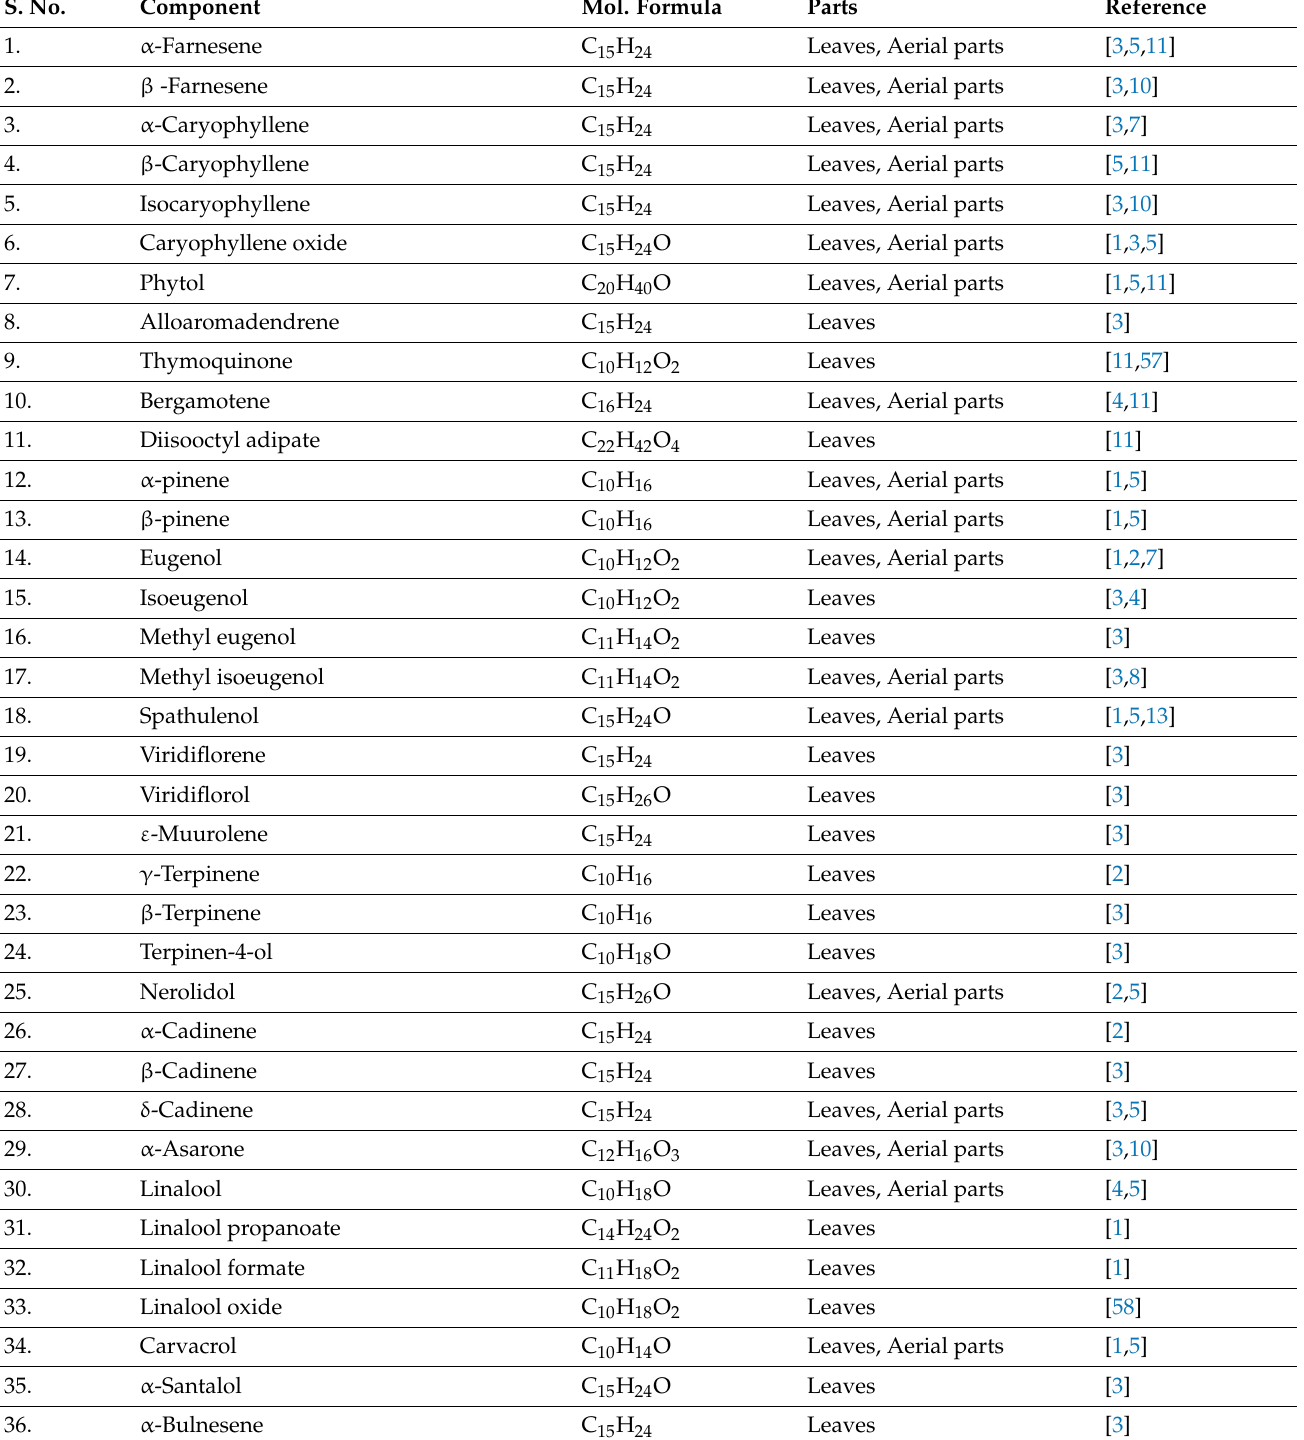
Table 2. Different volatile components present in the leaves and aerial parts of P. frutescens